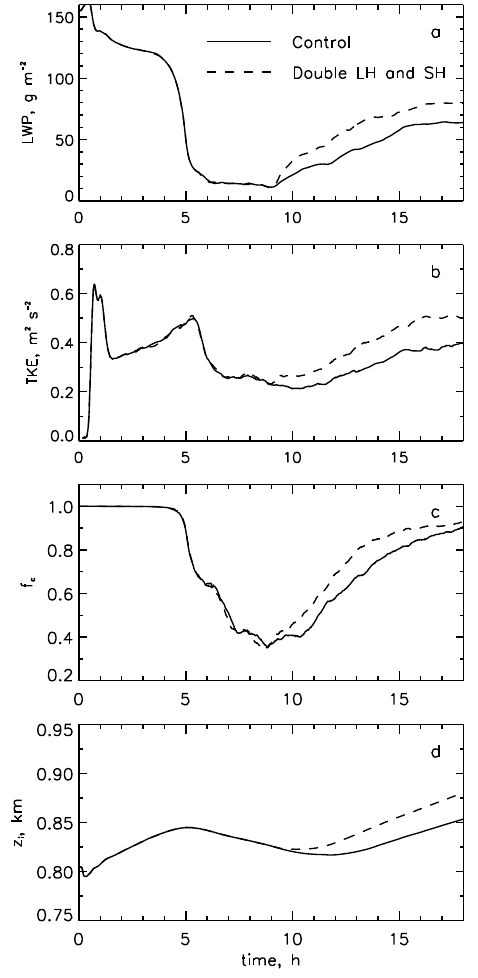
Figure 10. Simulations considering the influence of surface forcing on recovery. Solid line: control simulation; dashed line: latent and sensible heat fluxes are double their interactively calculated values after t = 9h, i.e., concurrent with the increase in N